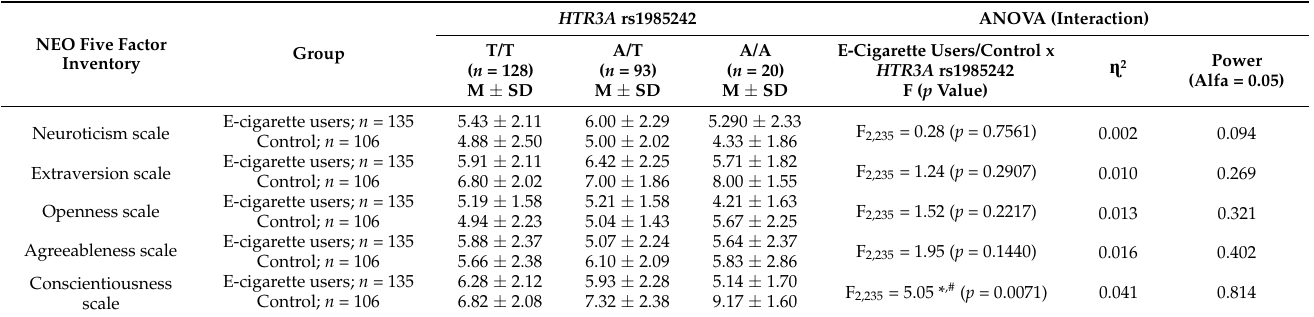
Table 4. The results of 2 × 3 factorial ANOVA for e-cigarette users and controls, NEO Five Factor Inventory and HTR3A rs1985242.